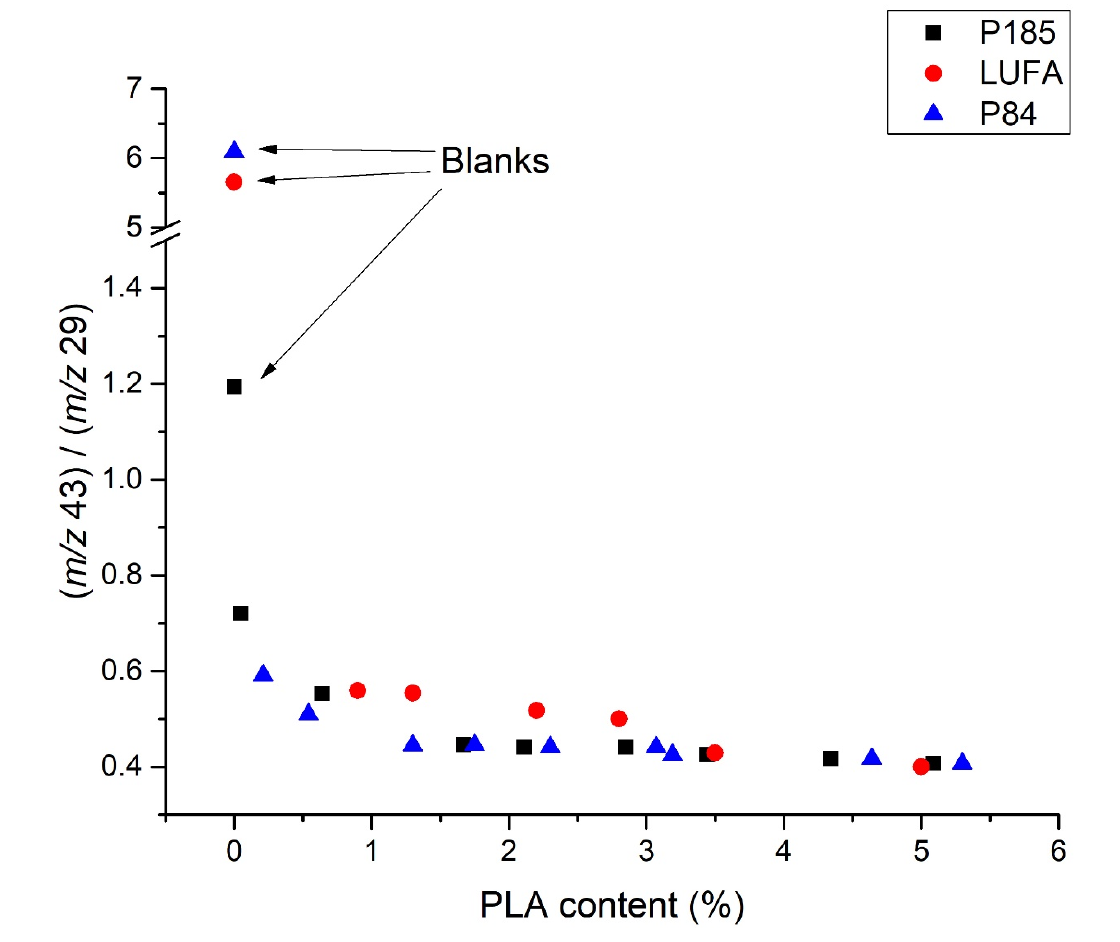
Figure 6. Ratios of PLA peaks of ions with m / z 43 and 29 in different soils as a function of MBP concentration.